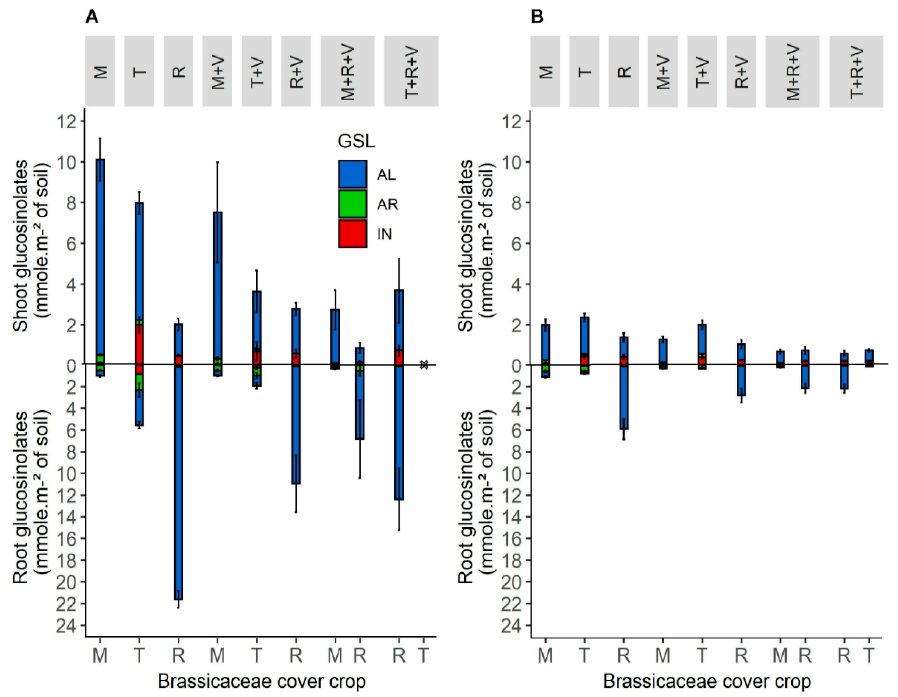
Figure 3. Mean shoot and root glucosinolates production function of the total dry matter biomass of each species of Brassicaceae cover crop per square meter of soil (mmol m − 2 of soil) in sole crops and mixture with vetch in 2019 ( A ) and 2020 ( B ). In 2019, the turnip rape did not grow in the mixture with fodder radish and purple vetch. Abbreviation letter refers to cover crop species with M for brown mustard, T for turnip rape, R for fodder radish and V for purple vetch. Error bars represent standard errors.